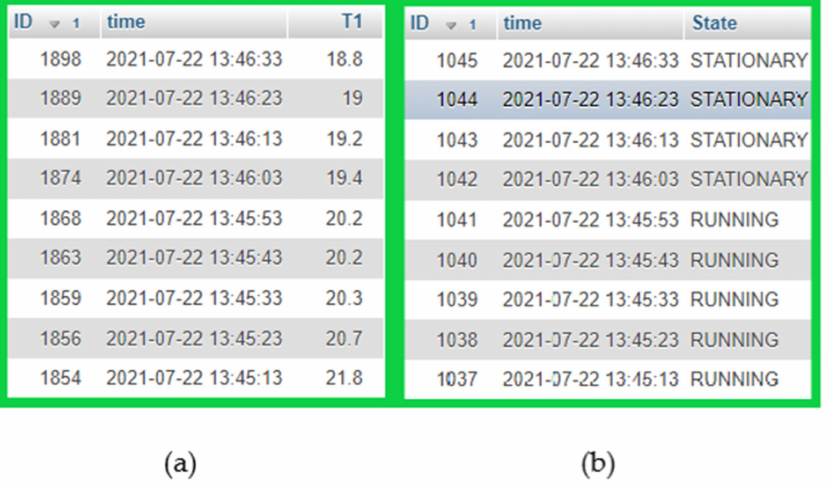
Figure 12. Database sample of temperature readings ( a ) and 3D model state ( b